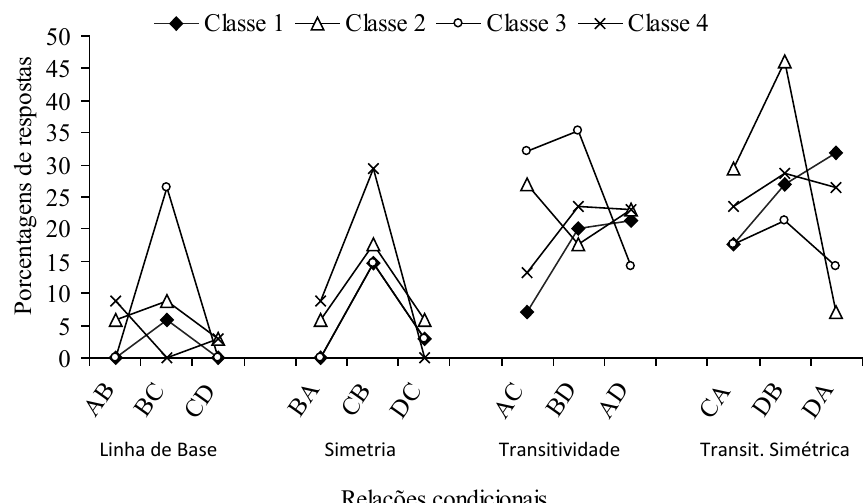
Figura 1 . Porcentagens médias de respostas incorretas nos testes das relações condicionais emergentes de linha de base (AB, BC e CD), simetria (BA, CB, DC), transitividade (AC, BD, AD) e transitividade simétrica (CA, DB, DA) das classes 1, 2, 3 e 4.